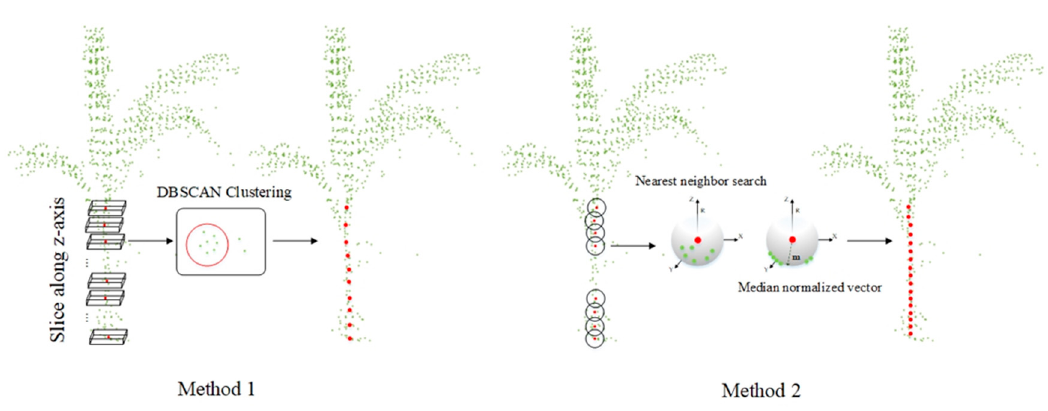
Figure 8. Regional growth